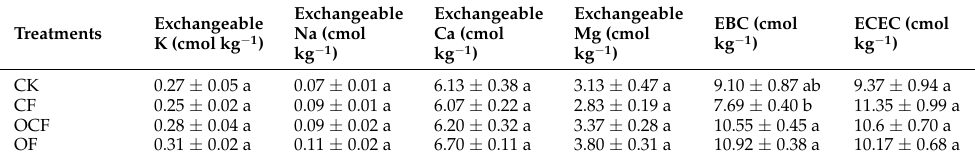
Table 3. Changes in exchangeable K + , exchangeable Na + , exchangeable Ca 2+ , exchangeable Mg 2+ , exchangeable base cations and ECEC under different fertilization treatments.